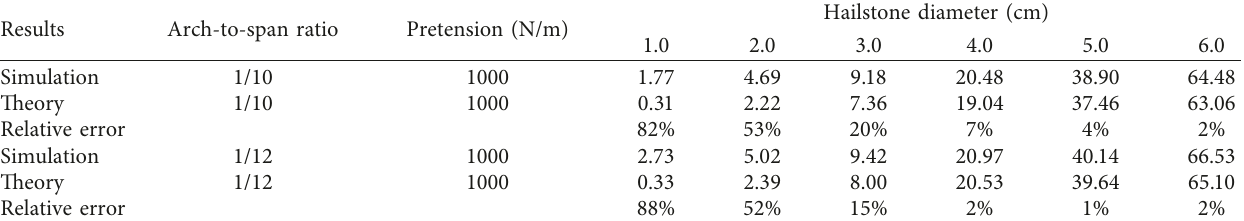
Table 7: Comparison of impact point maximum displacement results (mm) between numerical simulation and theoretical solution. Results Arch-to-span